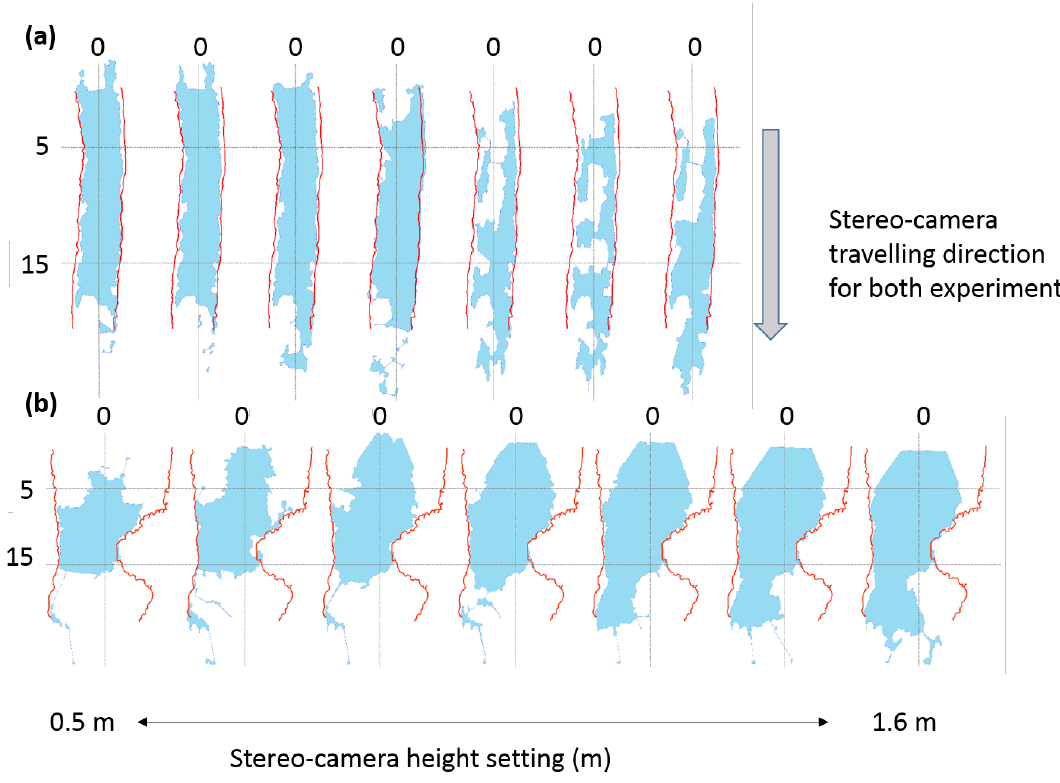
Figure 9. Water surface area footprint (blue) obtained for each stereo-camera height setting during the 10 m reach calibration studies at: ( a ) the Chicheley Brook site; and ( b ) the River Ouzel site. The stereo-camera height settings tested from left to right are 0.5 m, 0.6 m, 0.8 m, 1.00 m, 1.2 m, 1.4 m and 1.6 m. All coordinates provided are